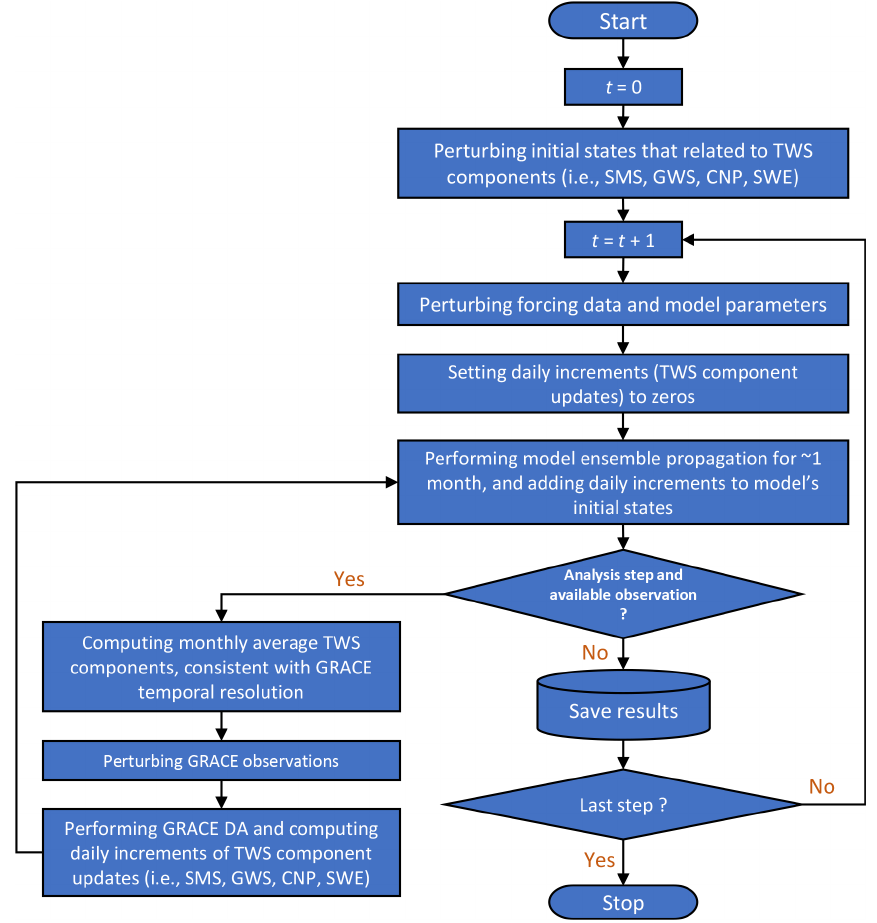
Figure 3. The data-processing diagram of the GRACE DA